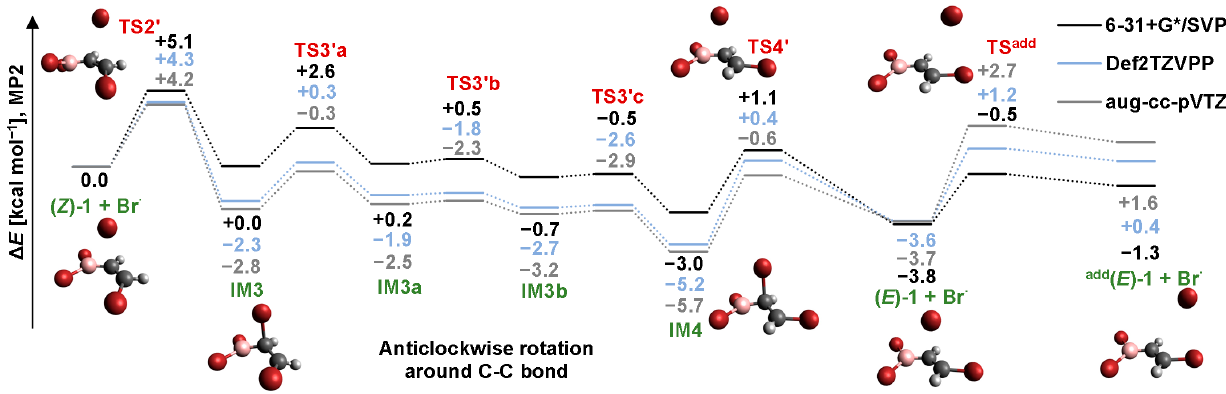
Figure 9. MP2 total electronic energy profile for bromine radical addition to the “boron end” of ( Z )-1 followed by anti- clockwise rotation around the C–C bond. For a key to atom color scheme, cf. caption of Figure 1.